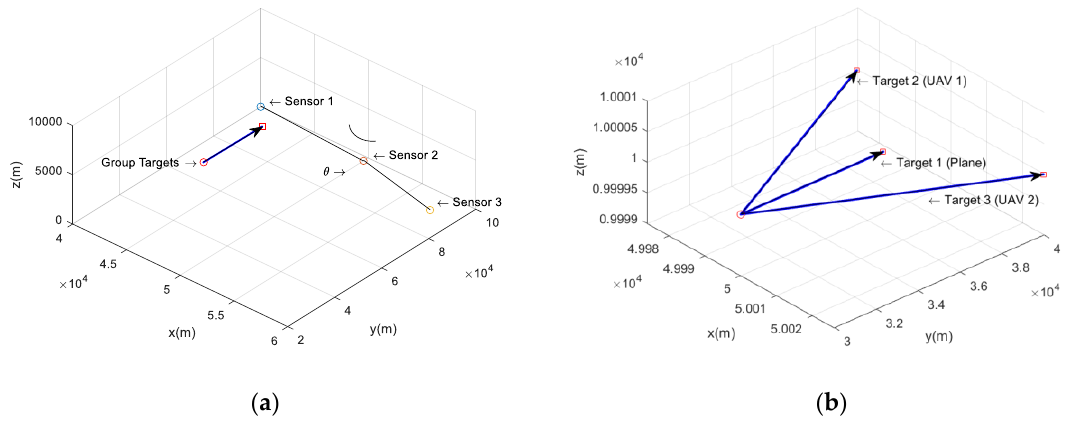
Figure 6. Geometry of the scenario. ( a ) Overall scenario of three deployed sensors and group targets; ( b ) detailed motions of the three aerial targets.